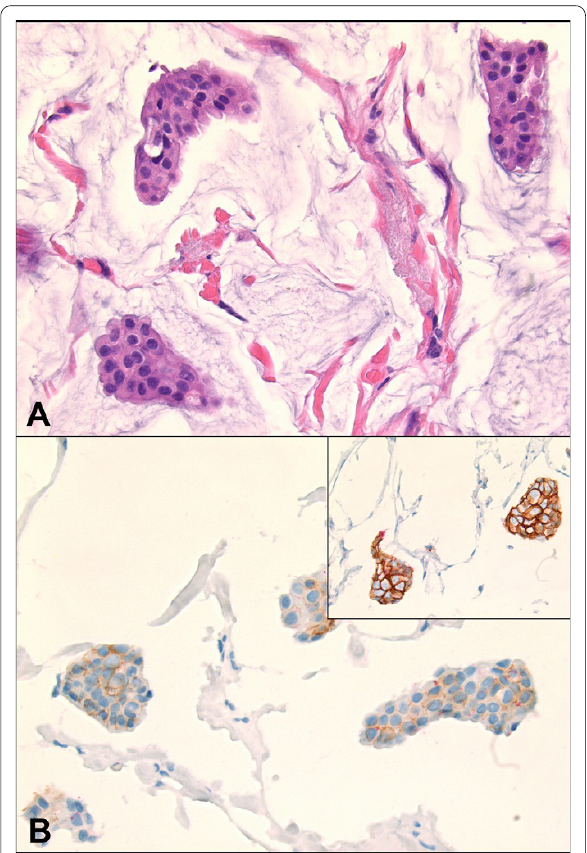
Figure 3 Cases of pure mucinous carcinoma with significantly re- duced membranous E-cadherin and p120 staining without redis- tribution of p120 into cytoplasm (A, H&E, ×400; B, inset is a typical mucinous carcinoma with strong membranous E-cadherin staining, immunohistochemistry,